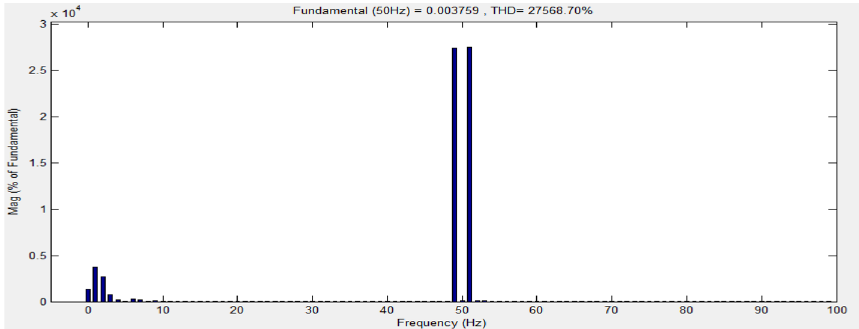
Fig. 14 FFT analysis (presence of 49 and 51 Hz) of received voltage after injection of Lock-in signal